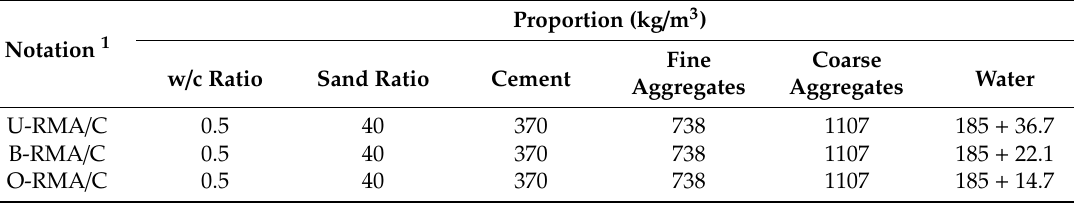
Table 1. Proportions of concrete